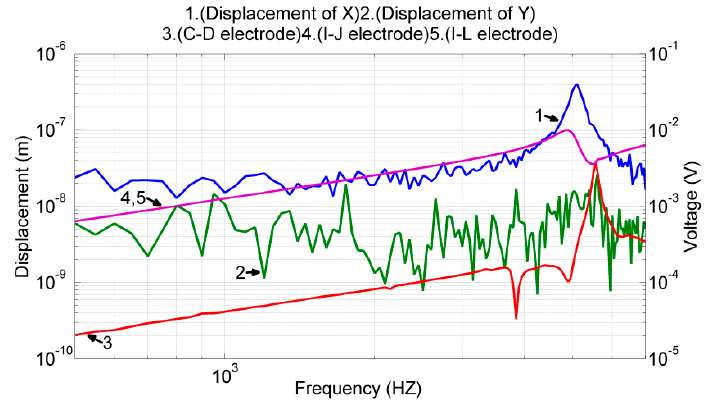
Figure 14. Frequency response of the proof mass displacement and frequency response of the voltage